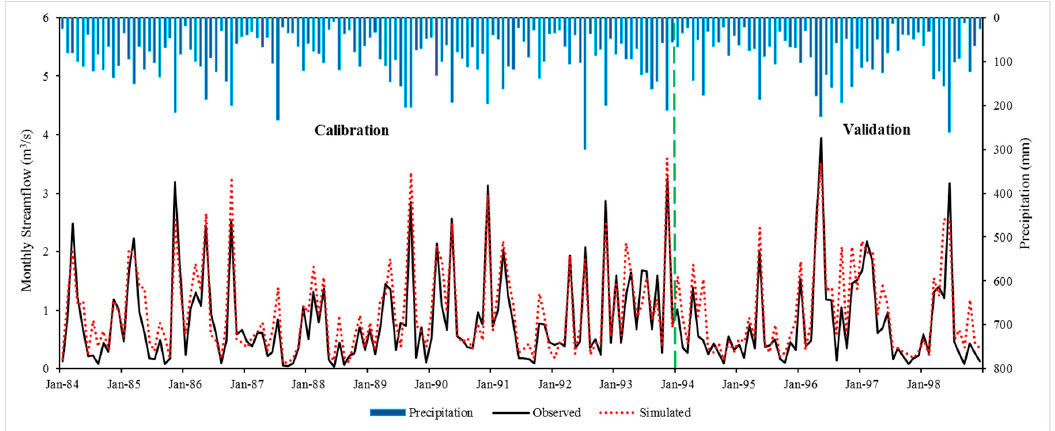
Figure 6. Observed and simulated streamflow of LEC watershed for calibration and validation period. Table 8. Values of statistical indicators in the calibration and validation periods for streamflow and baseflow in the LEC